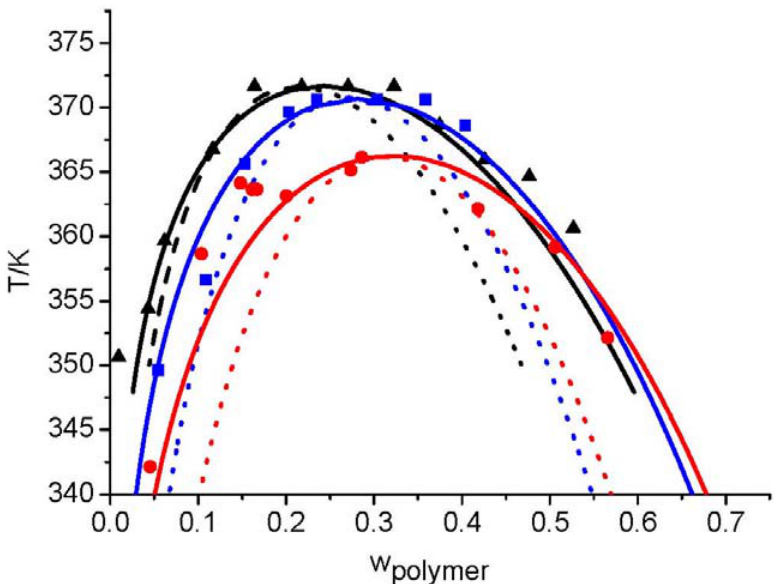
Figure 8. Phase behaviour of Boltorn H20 in different solvents (water: black triangles [54], propan-1-ol: blue squares [54], butan-1-ol: red circles [58]). The dotted lines are calculations based on LCT and the solid lines are calculations based on LCT + Wertheim approach, where the used parameters are listed in and Table 6